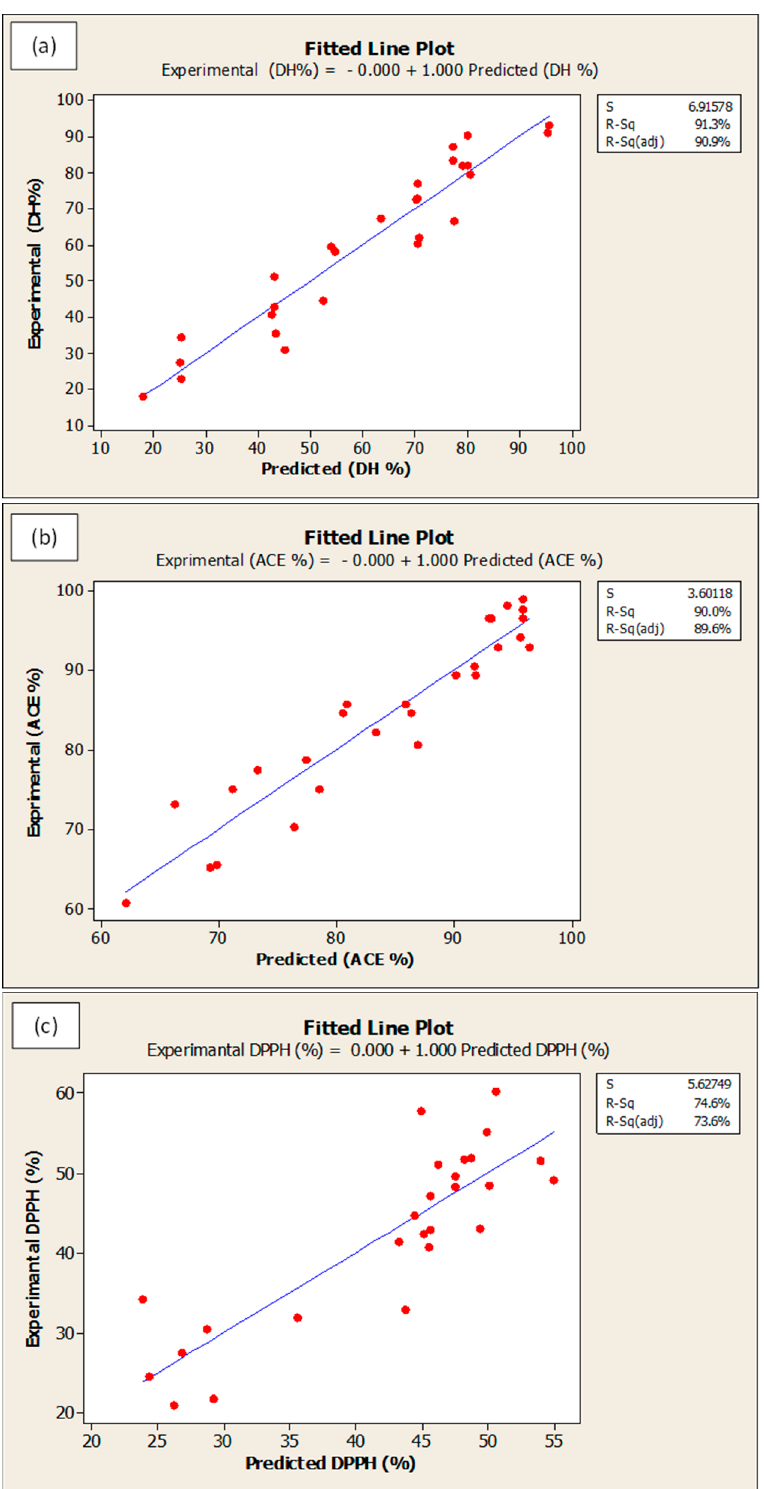
Figure 6. The predicted maximum responses (DH, ACE-inhibitory, DPPH• radical scavenging, ferrous ion chelating activity) based on predicted optimum hydrolysis parameters (temperature, E/S ratio, pH and hydrolysis time). Composite desirability = overall desirability encompassing all responses and d = individual desirability. Optimum hydrolysis parameters are denoted as red lines while the maximum responses are denoted as blue dotted